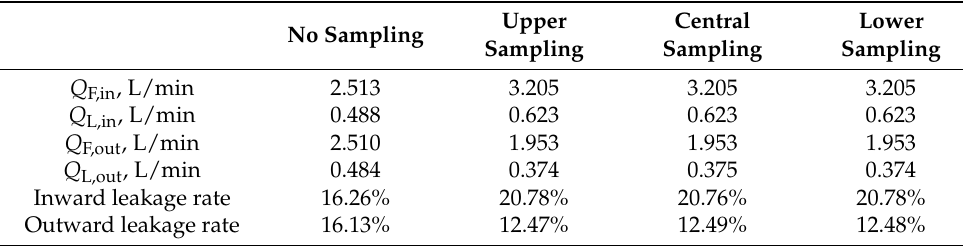
Table 2. CFD simulated exchanged air flow